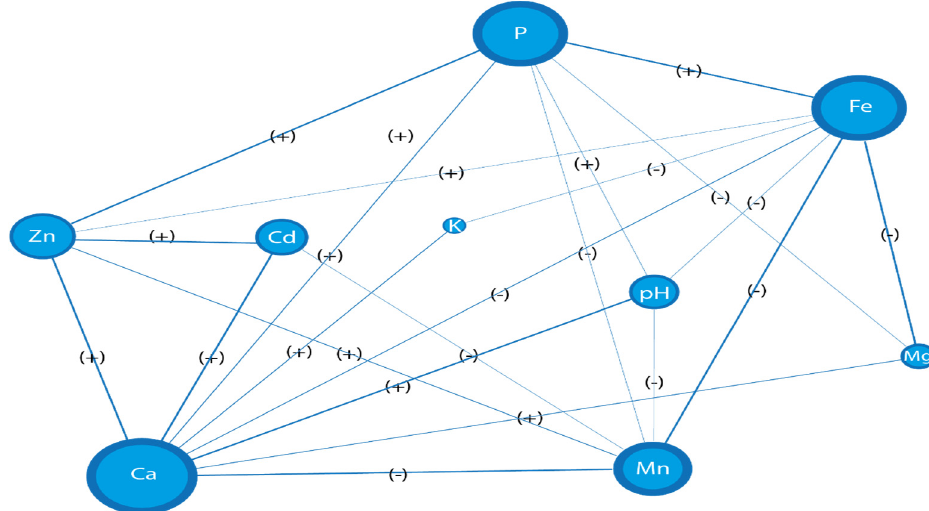
Figure 2. Inferred partial correlation network. Edge widths are proportional to the magnitude of the corresponding partial correlation coefficient whereas node sizes are proportional to the corresponding variable degree.